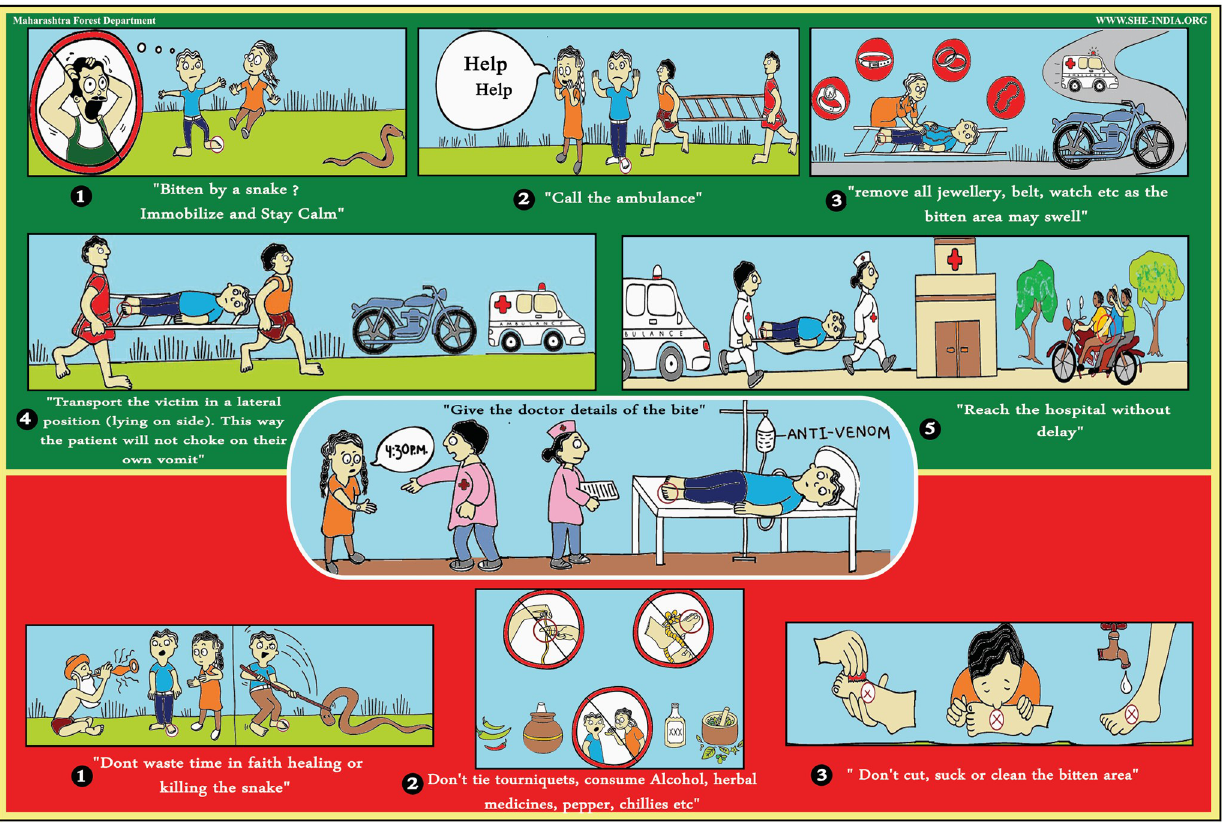
Fig 3. Example of clear, illustrative poster on snakebite awareness. This poster is available in 12 regional languages of India.